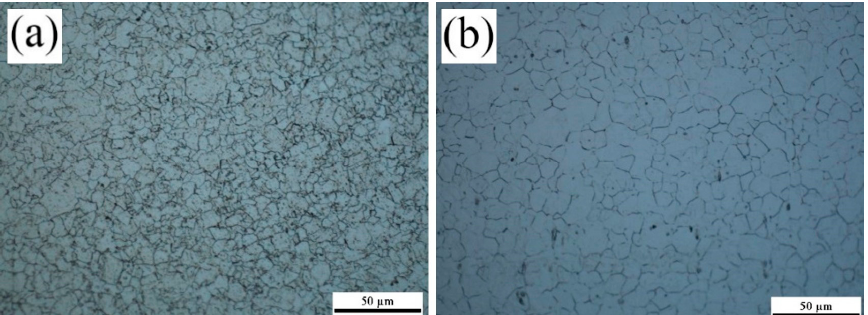
Figure 15. OM images of prior austenite grain of two investigated steels after heating for 5 min. ( a ) 22Mn3SiNb, 800 °C; ( b ) 22MnB5, 950 °C.